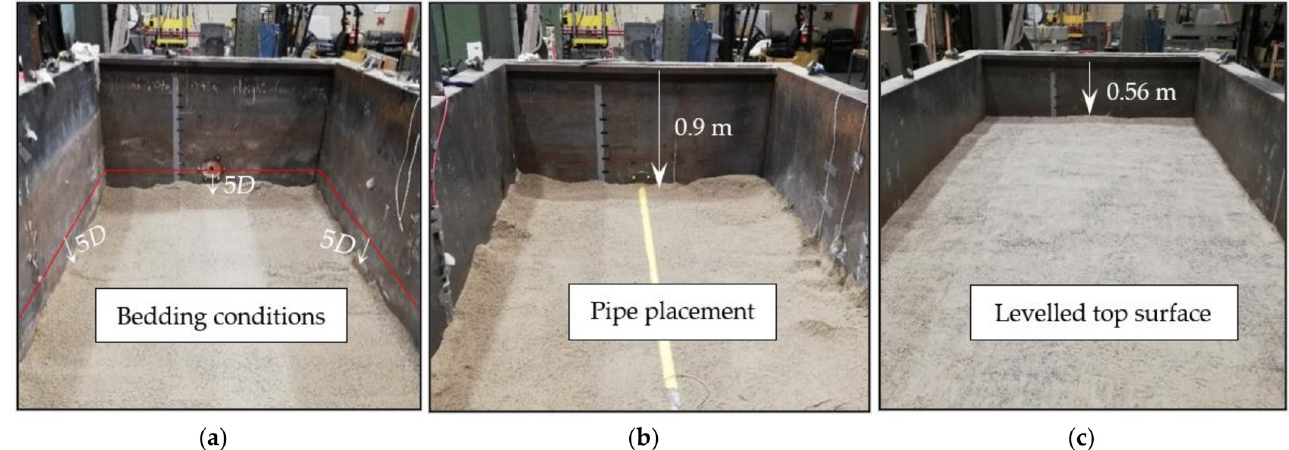
Figure 2. Test preparation (image by